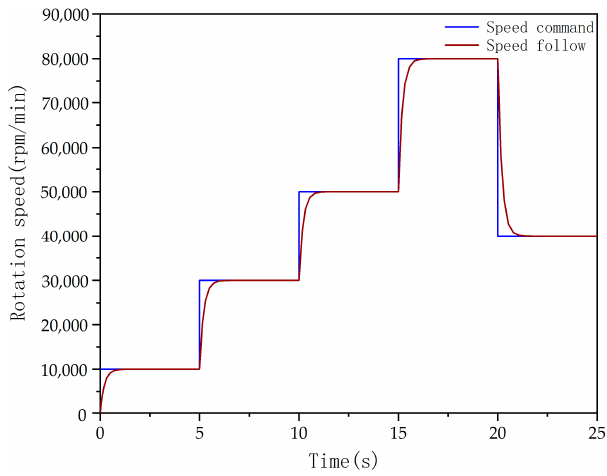
Figure 5. Dynamic response of compressor.